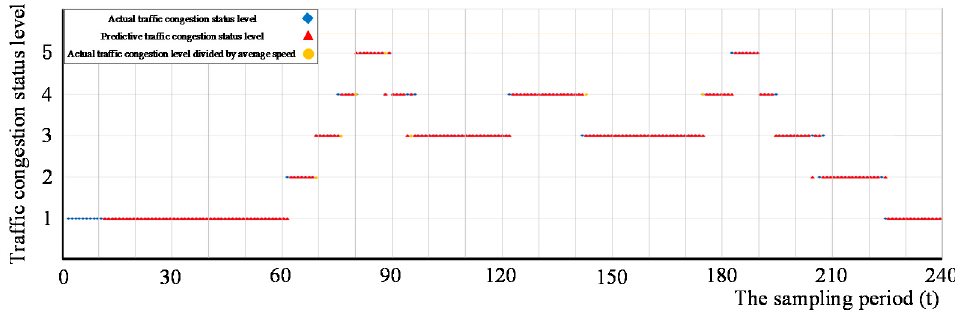
Figure 13. Weight of the traffic congestion evaluation index.